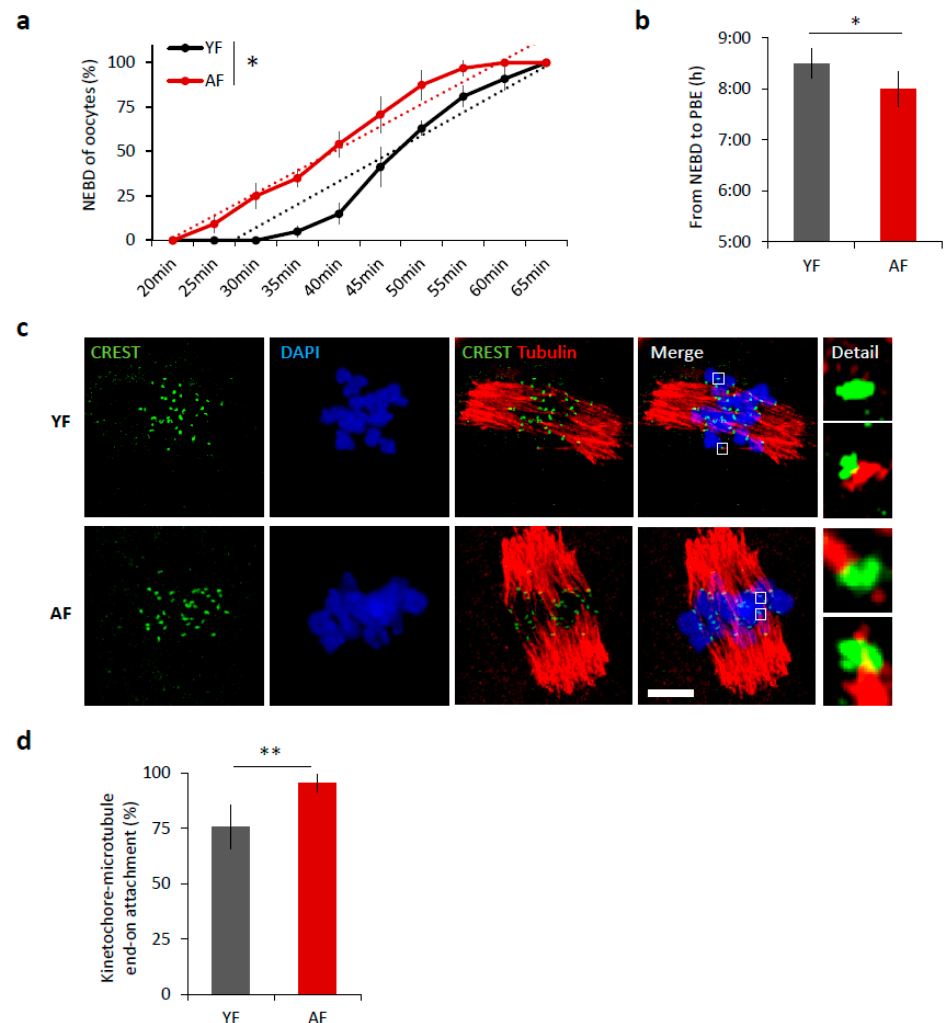
Figure 1. Meiosis I is accelerated in oocytes from females of advanced age. ( a ) Timing of nuclear envelope breakdown (NEBD) of oocytes isolated from young females (YF, n = 80; black line) and aged females (AF, n = 68; red line). Trend line is depicted by dot line. Data represent mean ± SD, n = 6, * p < 0.05, Student’s t- test. ( b ) Time from NEBD to polar body extrusion (PBE) in oocytes from YF ( n = 80; t = 8:30 h) and AF ( n = 68; t = 8 h). Data represent mean ± SD and data are from at least three experiments of biologically different samples. * p < 0.05, Student’s t- test. ( c ) Representative Z-projections from the assessment of cold stable attachments of kinetochore (KT) to microtubule (MT) imaged by confocal microscopy using CREST (green) and Tubulin (red) antibodies. Representative images from three experiments of biologically different samples are presented (scale bar, 10 µm). ( d ) The percentage of cold stable end-on MT to KT attachments in each age group averaged over multiple cells ( n ≥ 15) 6 h post-IBMX-wash. Kinetochore-MT end-on attachments were quantified. The morphology of kinetochores analyzed is specified in detail. Data represent mean ± SD. ** p < 0.01, Student’s t- test.